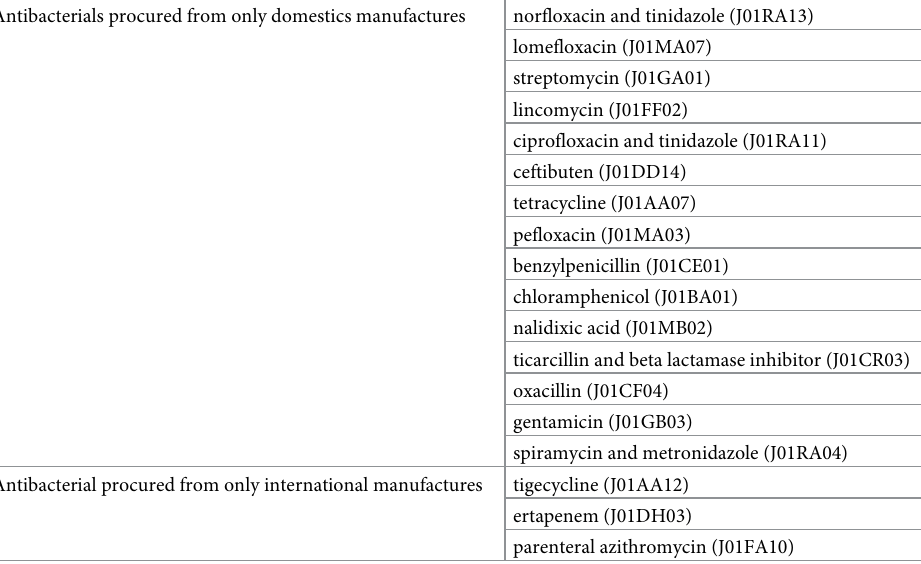
Table 4. Source of manufacturers for selected antibacterials. Antibacterials procured from only domestics manufactures